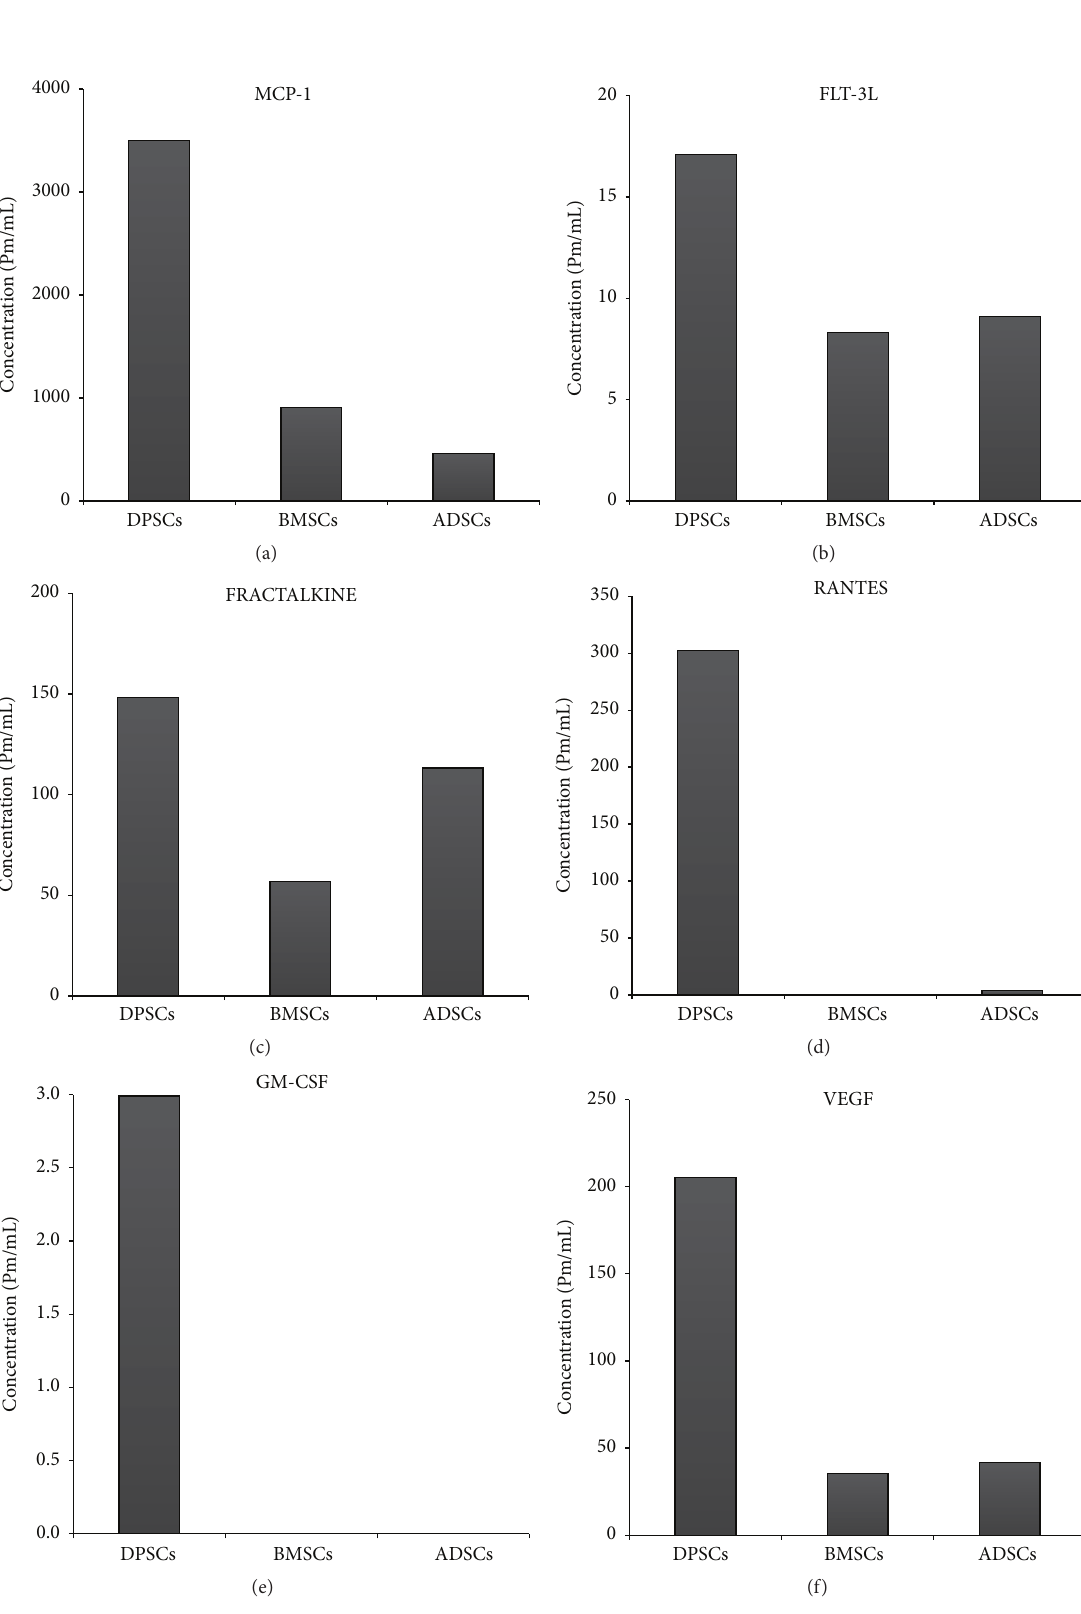
Figure 1: DPSCs secrete some cytokines and growth factors more than both BMSCs and ADSCs. (a) MCP-1. (b) FLT-3L. (c) FRACTALKIN. (d) RANTES. (e) GM-CSF. (f)